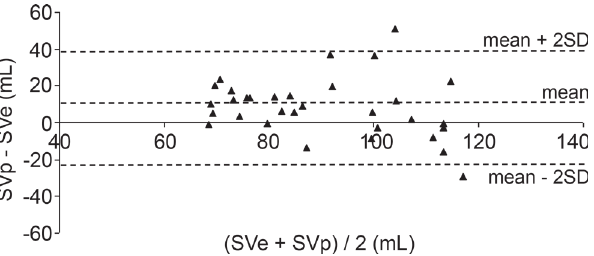
Fig 6. Bland-Altman plots for determination of agreement between SVe and SVp computed with the Windkessel algorithm. —— : limits of agreement (maximum, minimum,